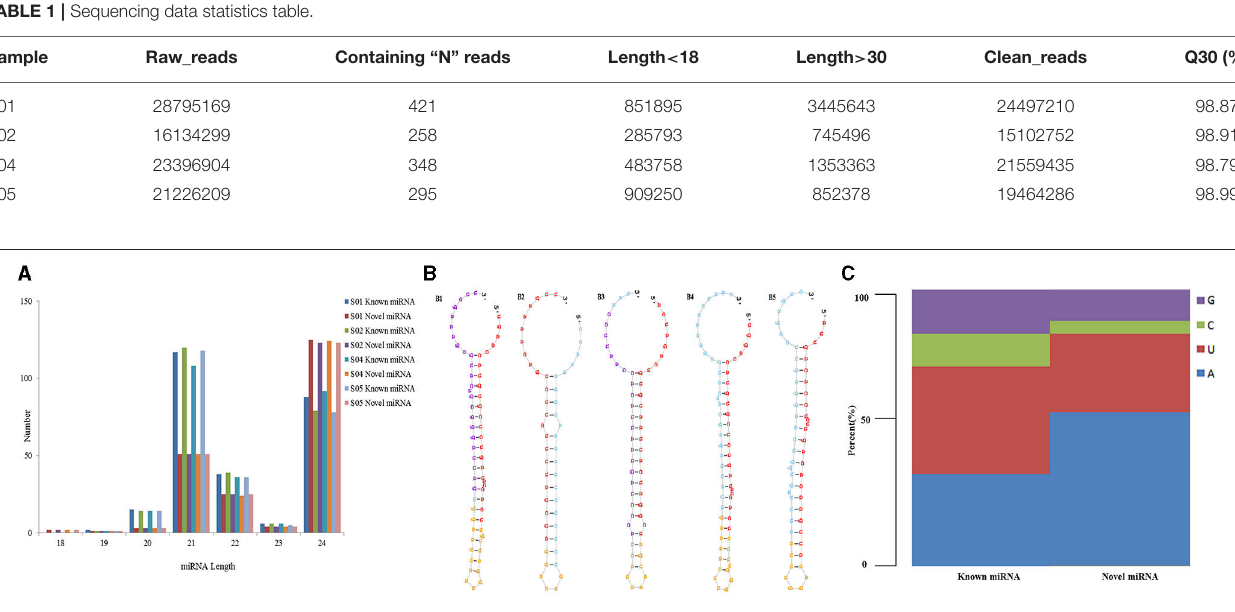
FIGURE 2 | The length distribution, stem loop structure, and first nucleotide base of miRNAs. (A) The length distribution of miRNAs; (B) is the stem loop structure of the candidate Novel miRNAs, B1 is the stem loop structure of unconservative_ST4.03ch04_17265; B2 is the stem loop structure of unconservative_ST4.03ch05_18175; B3 is the stem loop structure of unconservative_ST4.03ch05_20491; B4 is the stem loop structure of unconservative_ST4.03ch10_38333; B5 is the stem loop structure of unconservative_ST4.03ch12_44242; (C) The miRNA first nucleotide